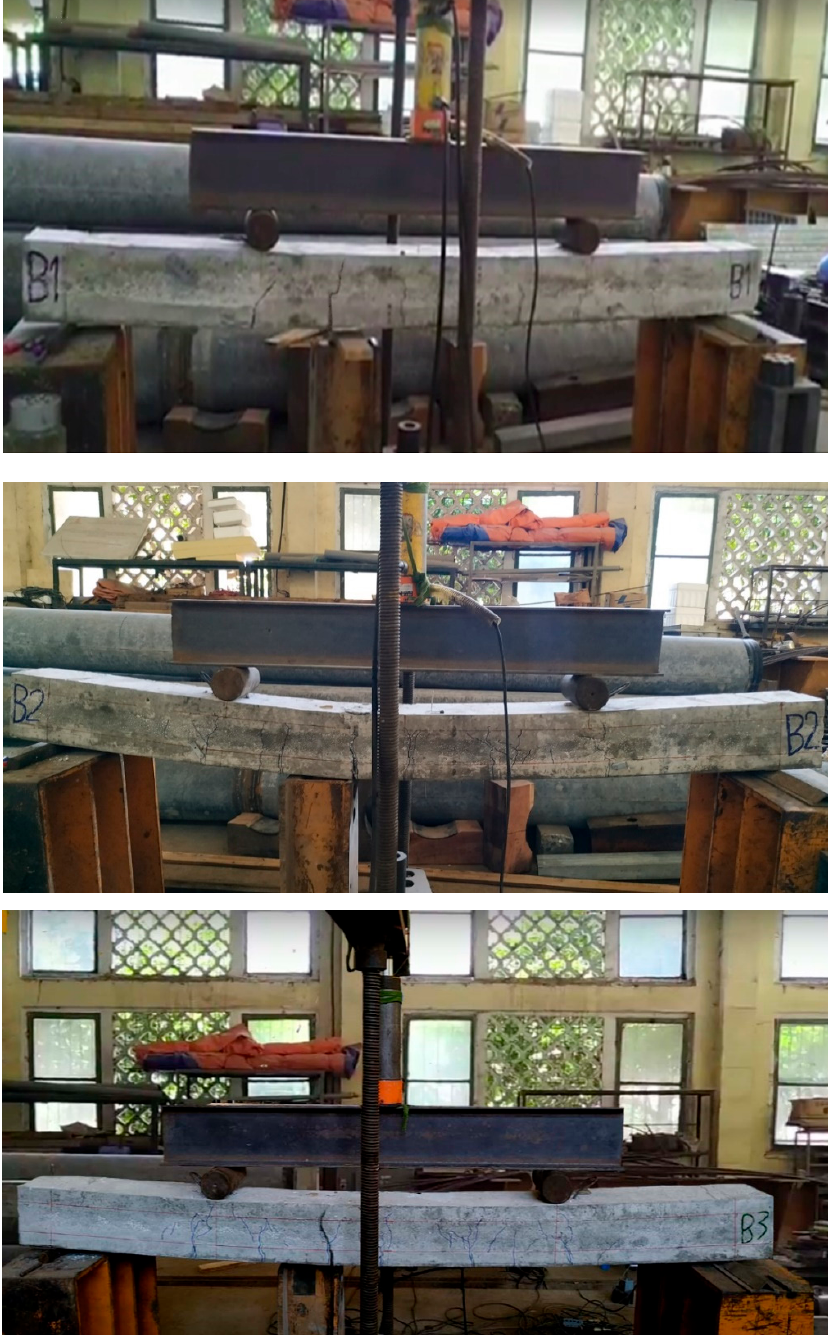
Figure 12. Views of the destruction of the tested beam